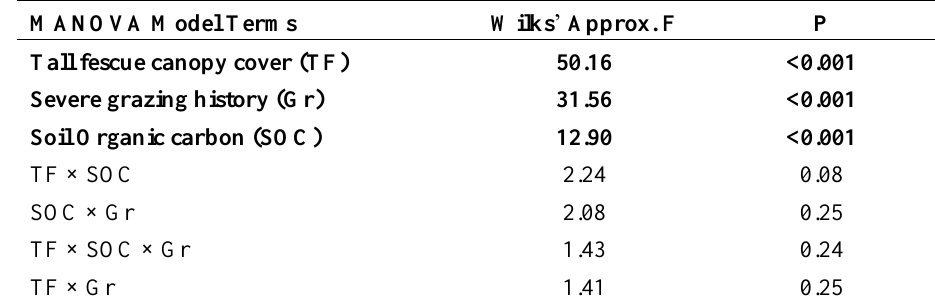
Table 2. Results of a Multivariate Analysis of Variance (MANOVA) model comparing tall fescue canopy cover, soil organic carbon, and grazing history effects on the position of modified Whittaker plot communities in ordination space (NMDS Axis 1 and Axis 2 site scores; see Figure 1) for nine grassland tracts in the Grand River Grasslands of southern Iowa and northern Missouri, USA. F statistics, approximated from Wilks’ lamba, rank the importance of model terms in explaining site scores. Boldface indicates significant terms in the MANOVA model.